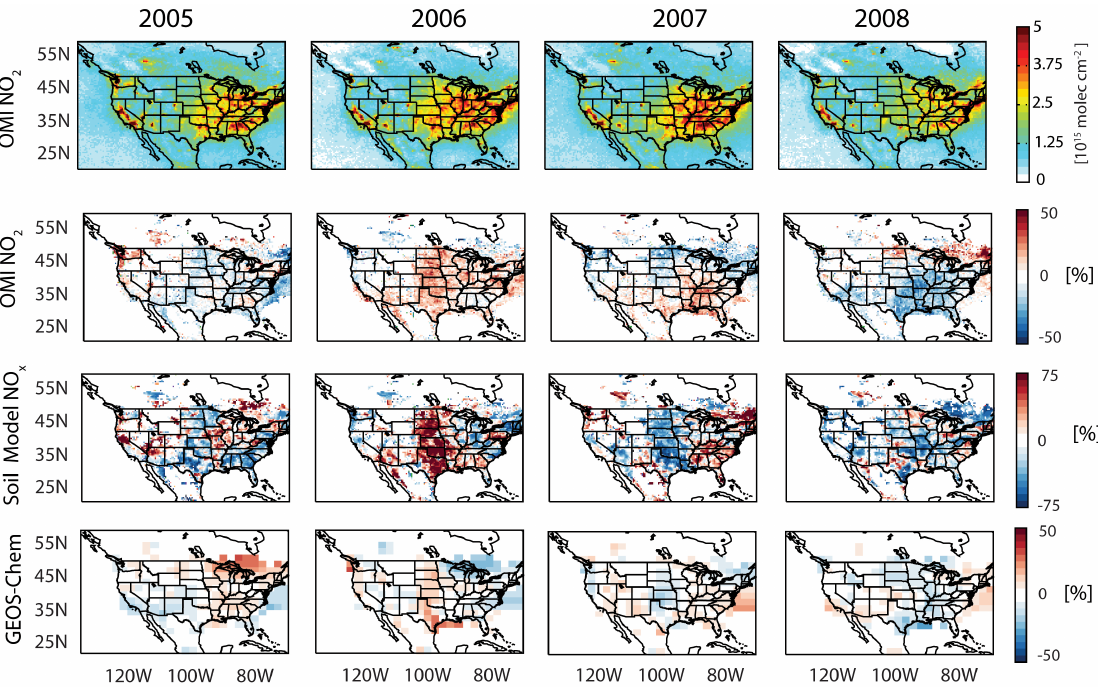
Fig. 3a. June mean OMI NO 2 column densities (top) are compared to mean anomalies for OMI NO 2 (middle) and Soil Model NO x emission (bottom), calculated as difference with June 2005–2008 mean. Only regions with mean June OMI NO 2 column > 1.25 × 10 15 moleccm − 2 are shown in anomaly plots. Color bar saturated at high and low